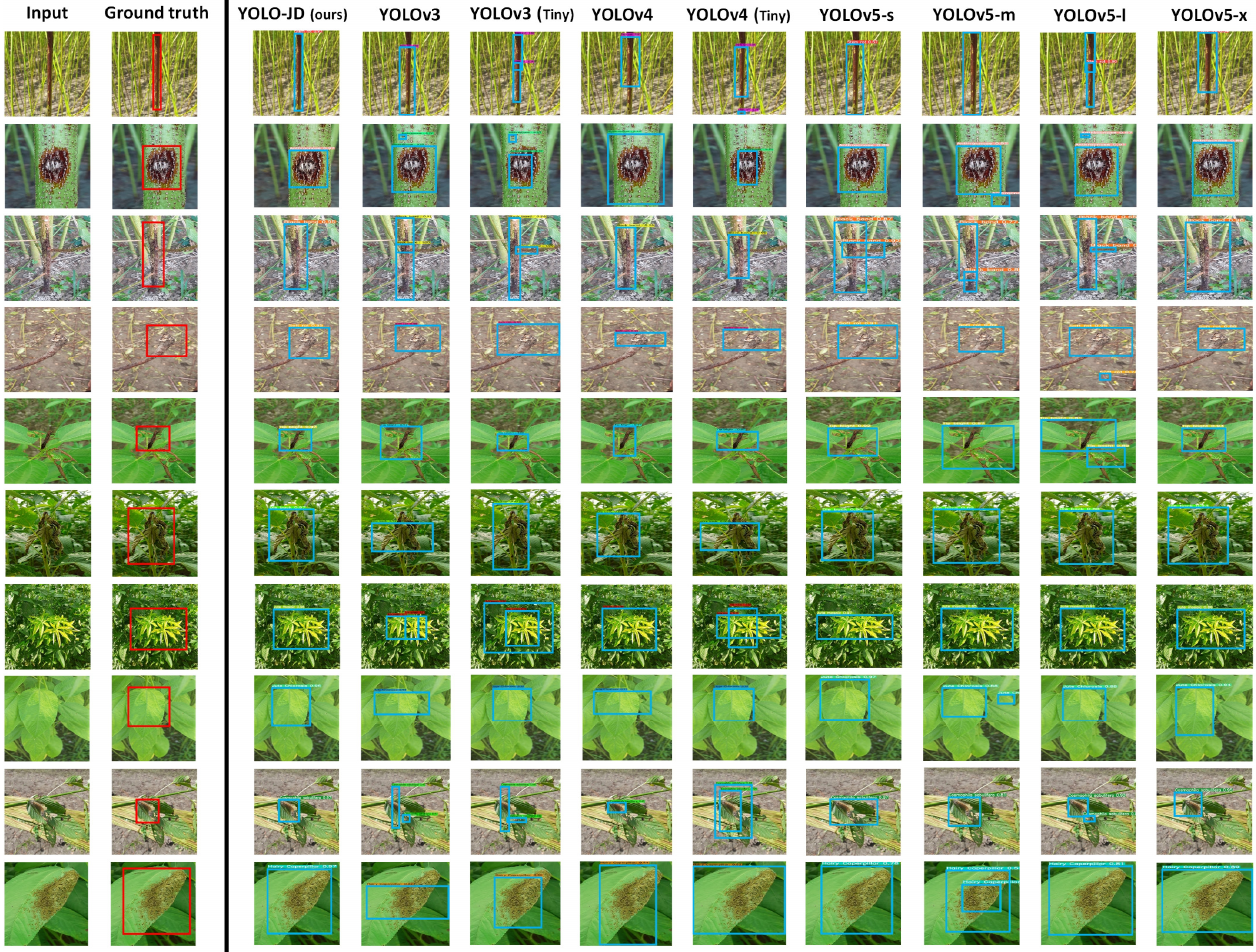
Figure 5. Qualitative comparison between our YOLO-JD and eight other models on Jute disease